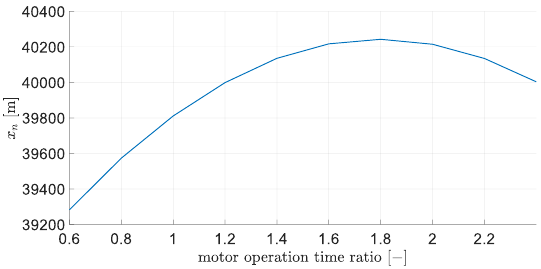
Figure 23 . Projectile range for various main motor thrust magnitude and duration combinations. Figure 23. Projectile range for various main motor thrust magnitude and duration